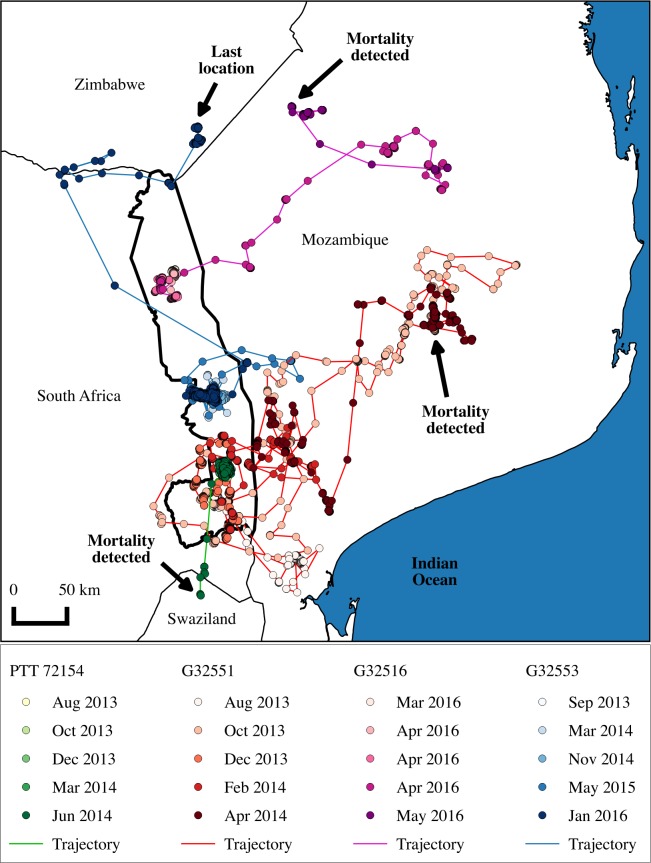
Movements of floater adult Martial Eagles (G32551 and G32516), and those that were territorial but vacated their territories (PTT 72154 and G32553) from KNP, showing the area covered during tracking.GPS locations are coloured by month to visualize movements through time (see bottom legend). The location of each bird’s death, or last known location, is also indicated.